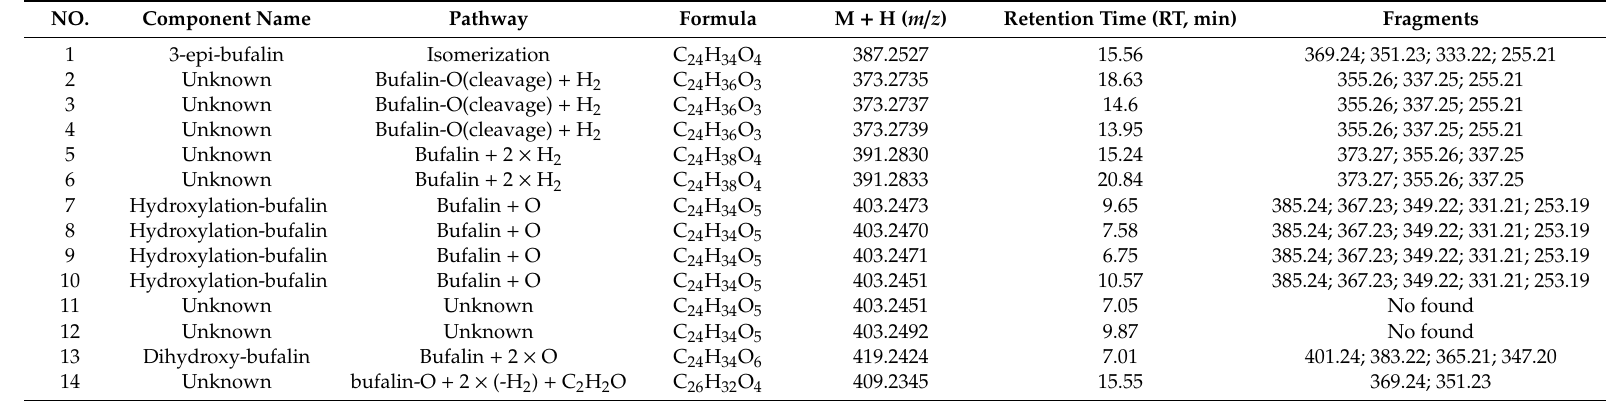
Table 1. The tentative characterization of metabolites of bufalin in rat plasma.